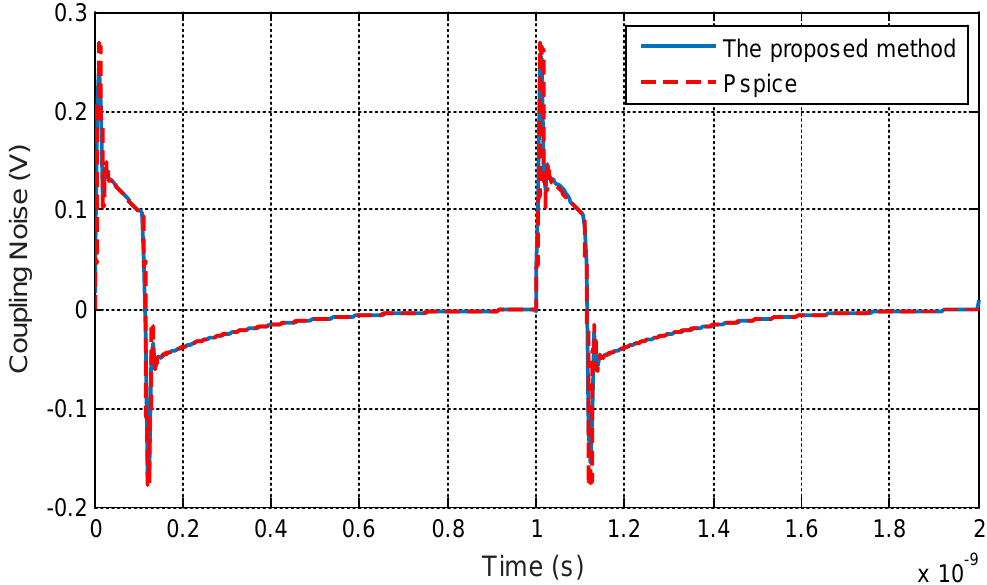
Figure 15. The proposed method and Pspice simulation of the TSV – TSV coupling noise with uncoupled RDLs ( l RDL = 200 µm) at port 3.